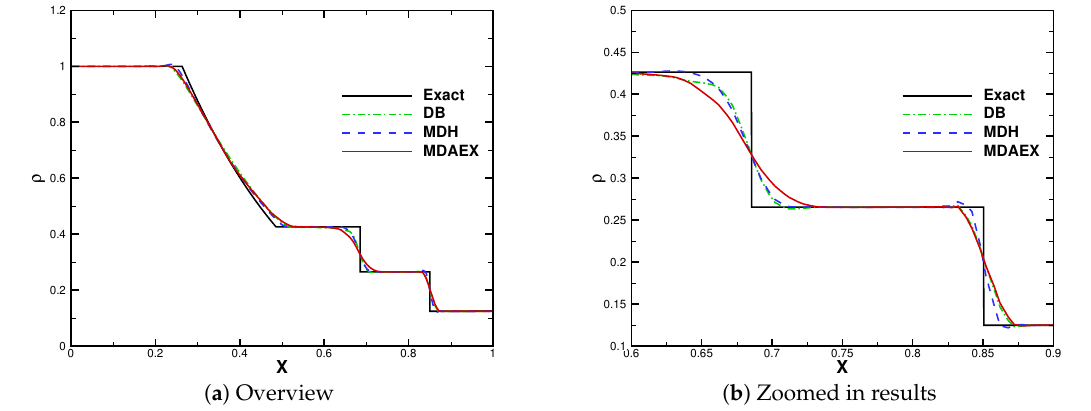
Figure 3. Density solution for the Sod problem with 100 elements at t = 0.2, P 1. ( a ) Overview; ( b ) zoomed in results.